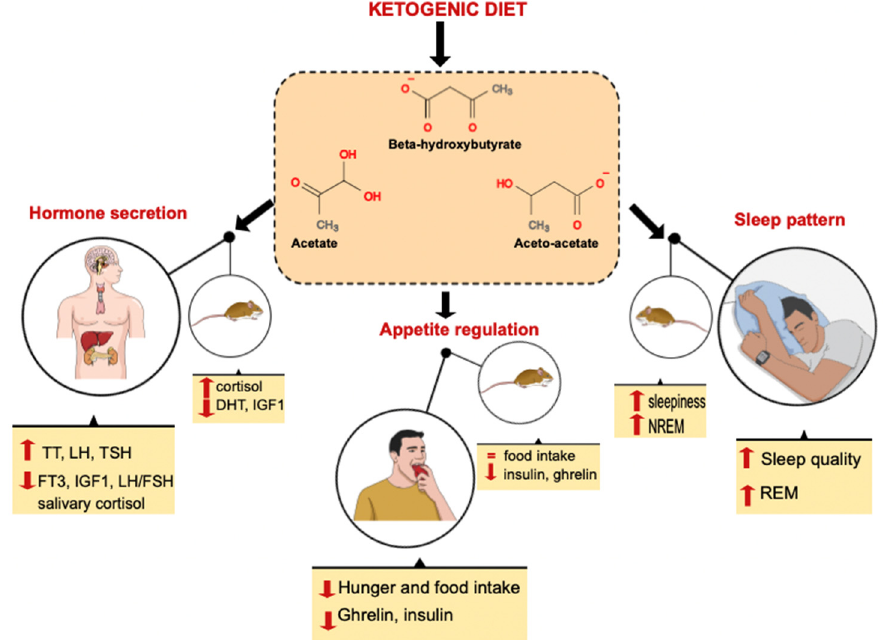
Figure 1. Evaluation of the effects of ketogenic diets on humans and mice in relation to three biological processes that follow circadian rhythms: appetite, sleep and endocrine function. Abbreviations: TT, total testosterone; LH, luteinizing hormone; FSH, follicle stimulating hormone; TSH, thyroid stimulating hormone; FT3, free triiodothyronine; IGF1, insulin-like growth factor 1; DHT, dihydrotestosterone; REM, rapid eye movement; NREM, non-rapid eye movement.